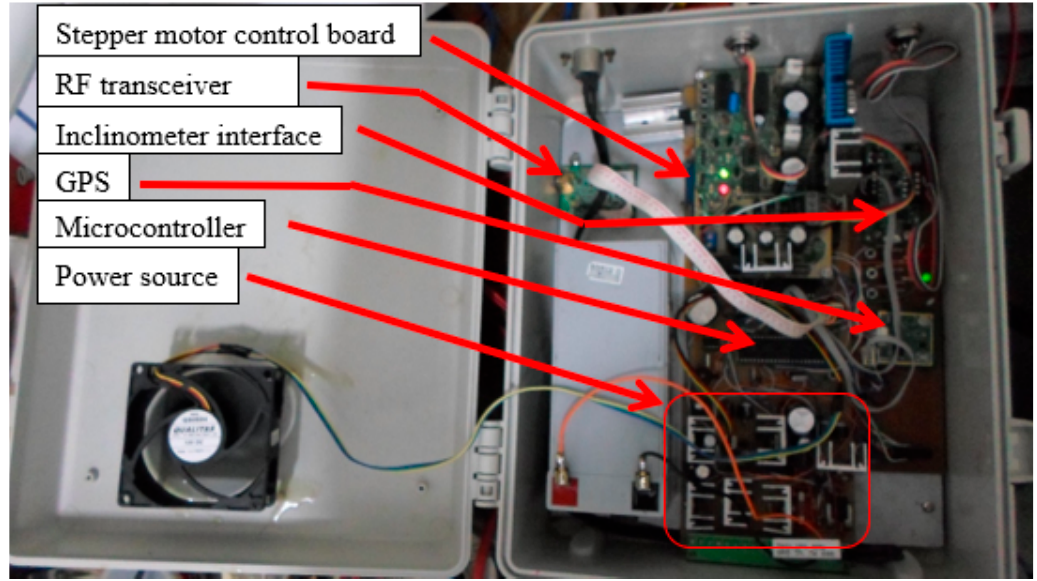
Figure 4. The electronics behind the flowchart.